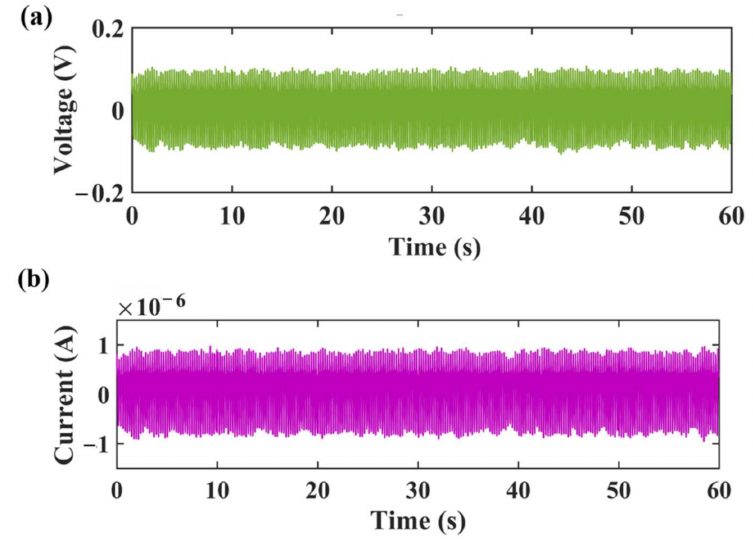
Figure 6. Variation of electric supply during disinfection: ( a ) output voltage vs. time plot and ( b ) current vs. time